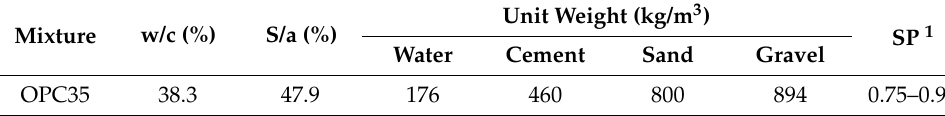
Table 2. Mix proportion of